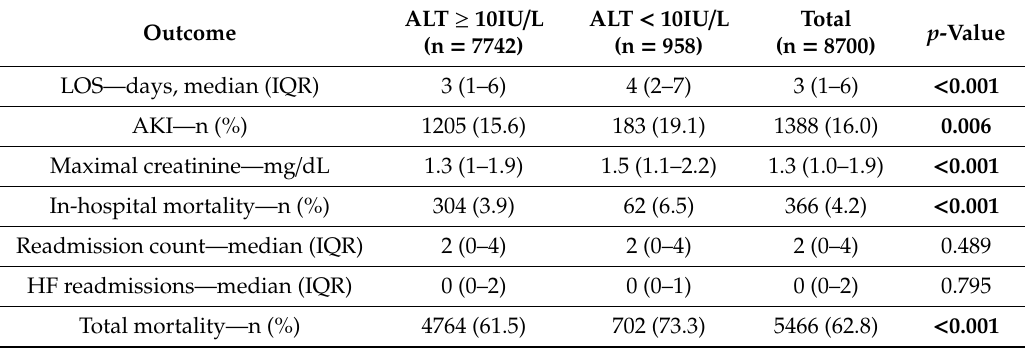
Table 2. Short-and long-term outcomes.